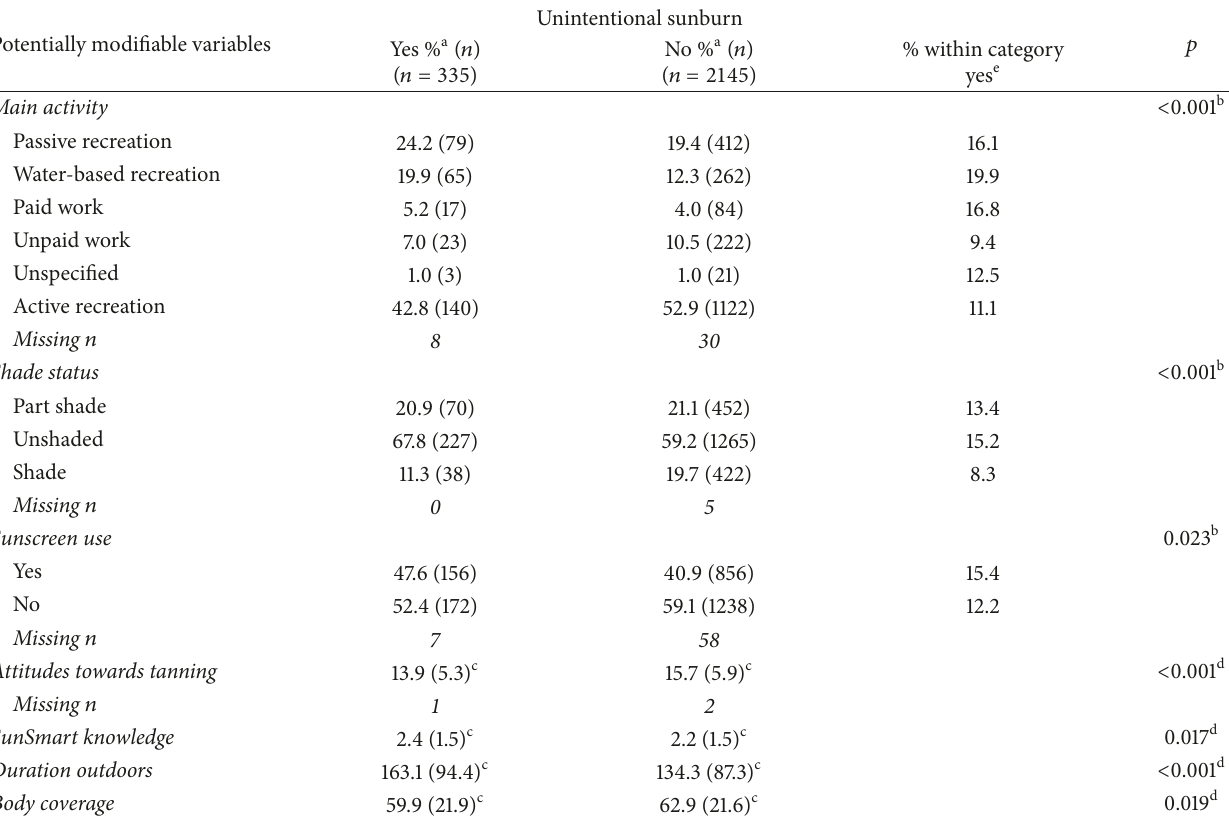
Table 2: Potentially modifiable respondent behaviours, attitudes, and knowledge for those sunburned inadvertently and those not sunburned (pooled over survey years 1999/00 to